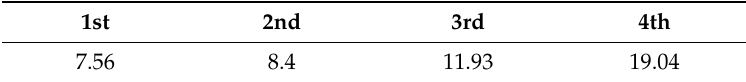
Figure 16. Acceleration PSDs for the Bridge Vibration Tests. ( a ) Test 1 and ( b ) Test 2. Table 4. Average bridge frequency (Hz).